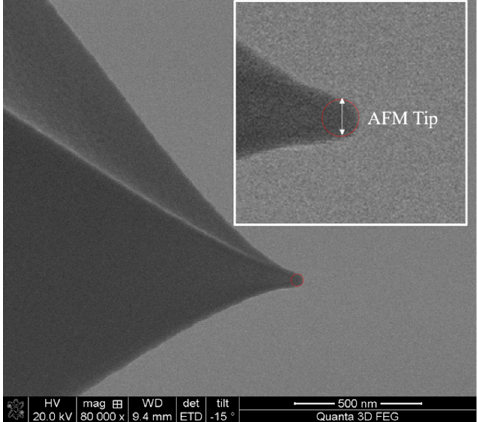
Figure 12. SEM micrograph of a gold-coated silicon nitride tip (in dark grey) used for AFM experiments. The area in the micrograph containing the tip apex was magnified (white box on the top right) to obtain a radius of ≈ 28 nm.